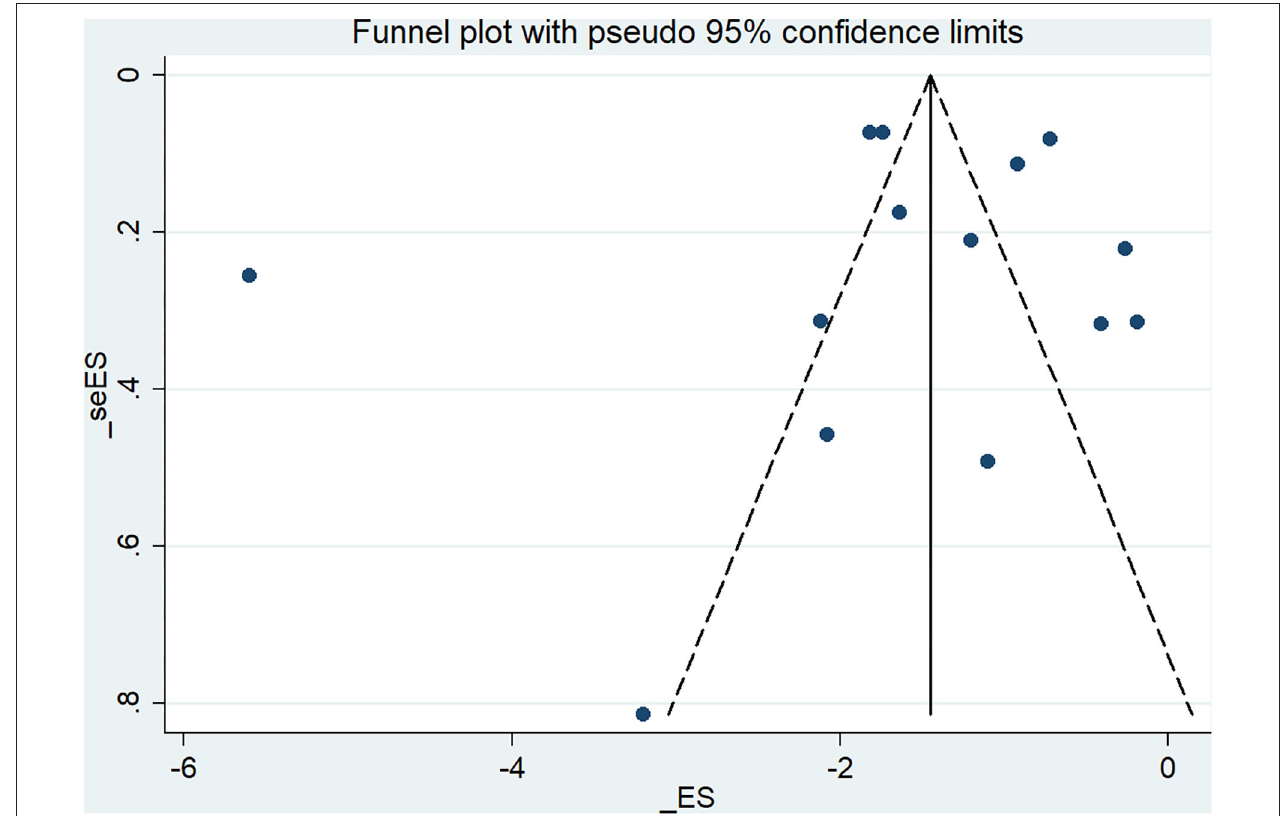
FIGURE 5 | Funnel plot of RCTs reporting migraine frequency at the end of